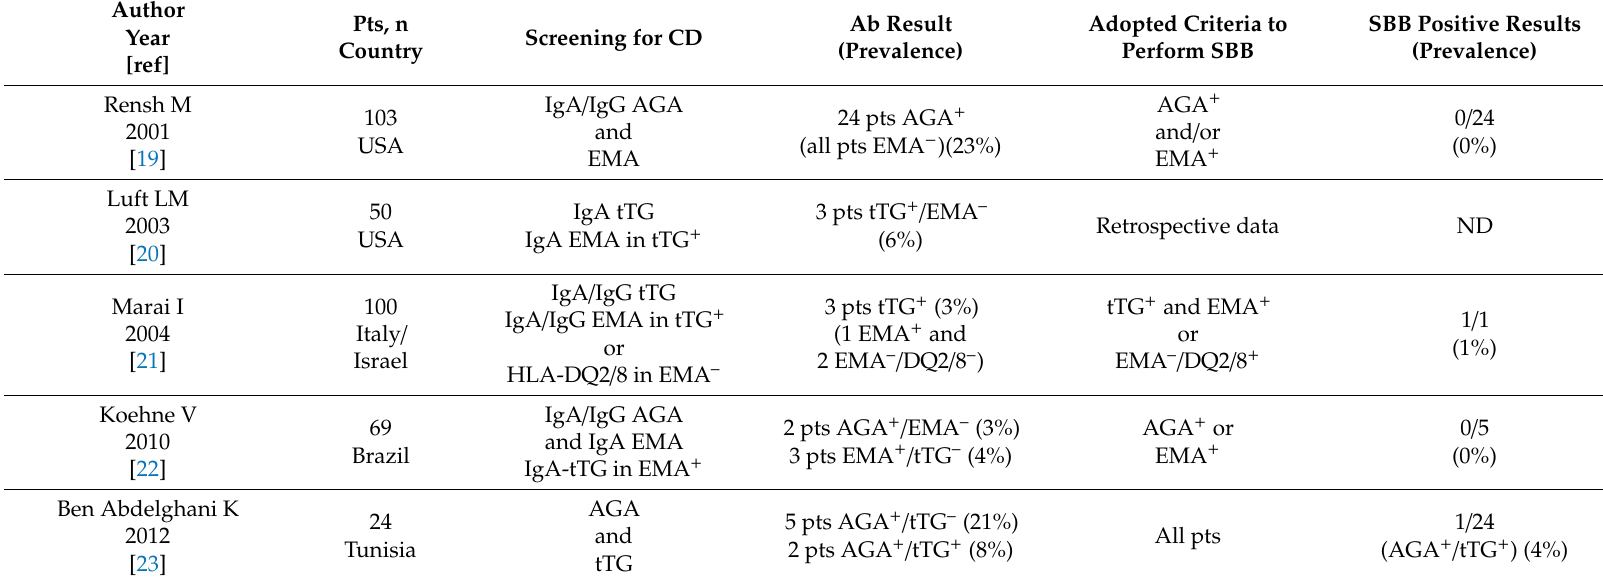
Table 1. Celiac disease prevalence in systemic lupus erythematosus.